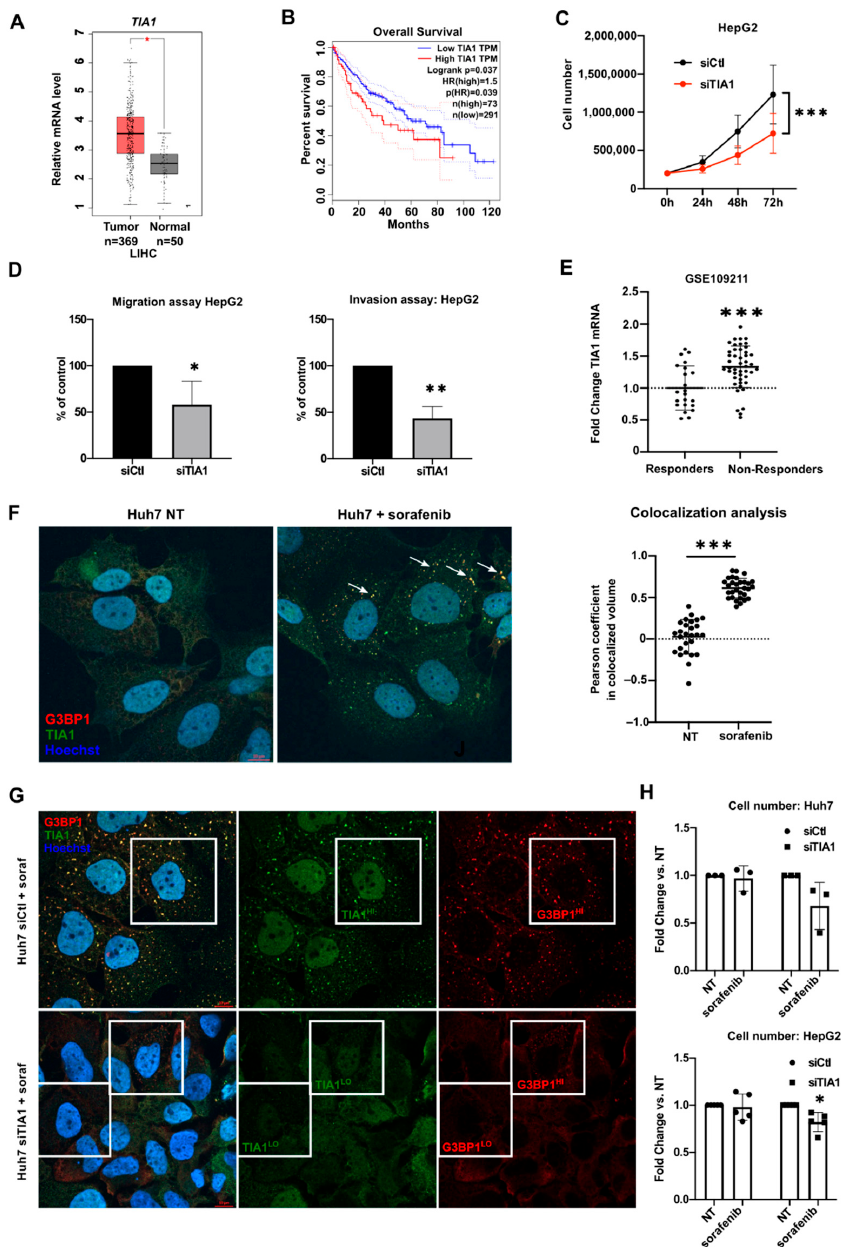
Figure 1. TIA1 deregulation in HCC and impact of TIA1 inhibition in vitro. ( A ) TIA1 expression in HCC tumors vs. healthy tissues (LIHC: TCGA cohort: GEPIA database retrieved 1 June 2021). ( B ) Overall survival of patients based on TIA1 expression in the LIHC cohort (GEPIA2, p -value calculated using the Log-rank test). ( C ) Cell number of HepG2 (n = 5) after TIA1 silencing (siTIA1) vs. control cells (siCtl). One-way ANOVA was used. ( D ) Percentage of HepG2 ± siTIA1 (n = 3) migrating through the Boyden chamber, not coated (migration, left) or coated (invasion, right) with Matrigel. ( E ) Relative mRNA expression levels of TIA1 in HCC patients responding to sorafenib vs. non-responders. ( F ) Representative pictures and quantification of TIA1 (green) and G3BP1 (red) signal colocalization in Huh7 ± sorafenib (n = 3). Arrows indicate stress granules. ( G ) Representative pictures of TIA1 (green) and G3BP1 (red) signal in Huh7 ± siTIA1 +. ( H ) Cell number of Huh7 (n = 3) or HepG2 (n = 5) after TIA1 silencing (siTIA1) vs. control cells (siCtl) and sorafenib treatment (24 h of transfection followed by 24 h of treatment with 20 µ M of sorafenib). * p < 0.05, ** p < 0.01, *** p <